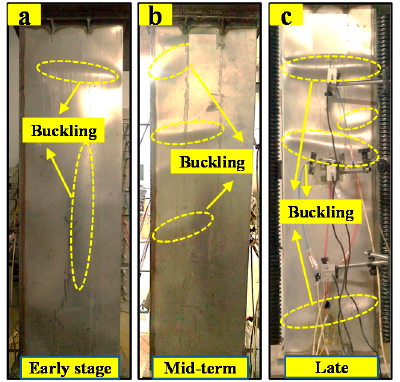
Figure 5. Z1 destruction phenomenon. ( a ) Early stage ( b ) medium stage ( c ) Late stage.